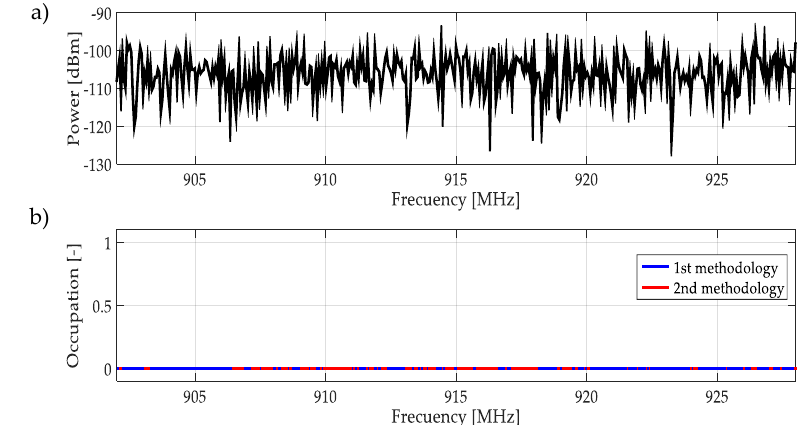
Figure 23. ( a ) A real signal obtained from the frequency band [902–928] MHz. ( b ) The result of applying both methodologies to the real signal in terms of spectrum occupancy. In this case, both methodologies do not correctly detect a PU.